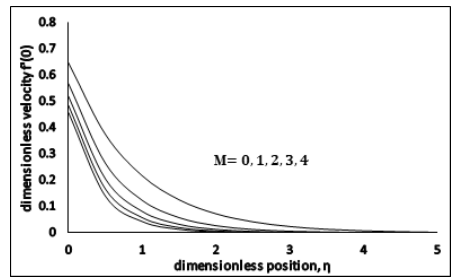
Figure 3. Dimensionless Velocity vs M .